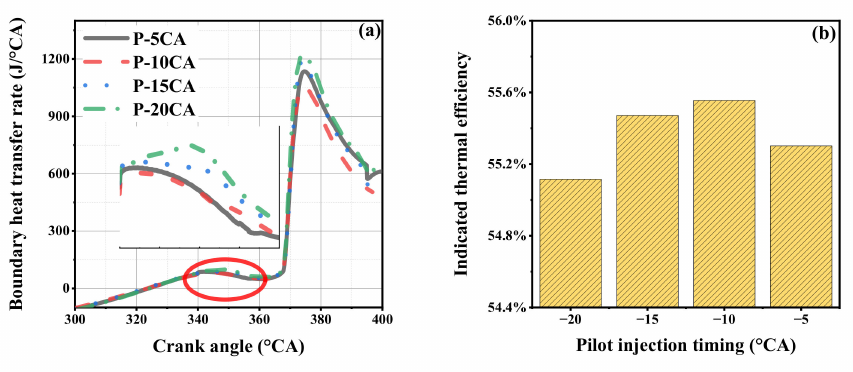
Figure 18. ( a ) Boundary heat transfer rate curves of different pilot injection timings, positive values represent that the heat flow was towards boundary ( b ) Indicated thermal efficiency of different pilot injection